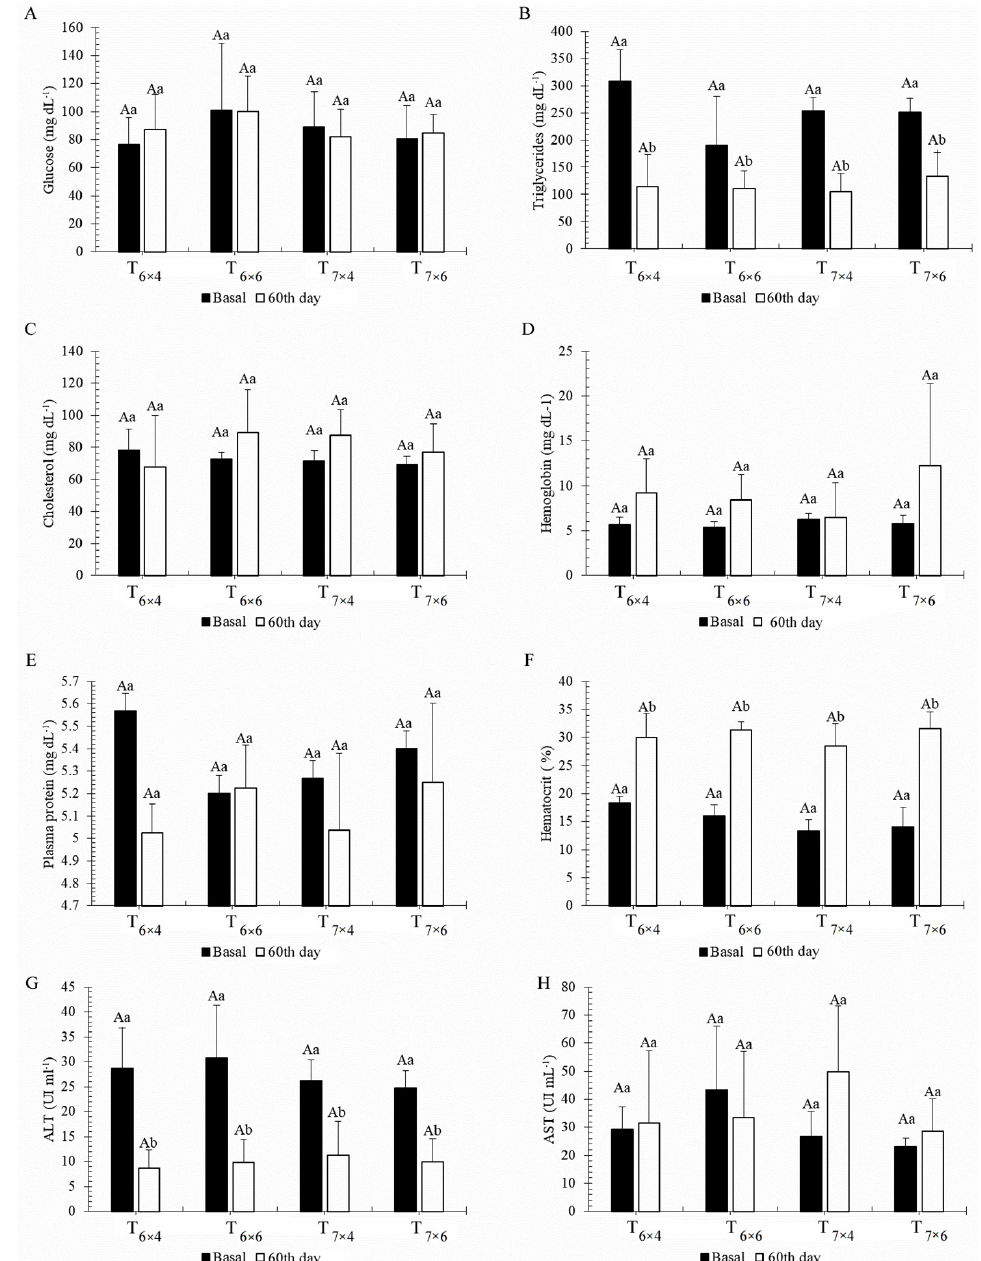
Figure 3. Blood parameters (basal and on day 60, Phase I) for Colossoma macropomum juveniles under different feeding frequencies and feeding rates: glucose ( A ), triglycerides ( B ), cholesterol ( C ), hemoglobin ( D ), plasmatic protein ( E ), hematocrit ( F ), ALT ( G ), and AST ( H ). Capital letters indicate significant differences between feeding regimes (treatments); lowercase letters indicate significant differences over time (between basal and day 60). Two-way ANOVA, Tukey’s test ( p < 0.05).